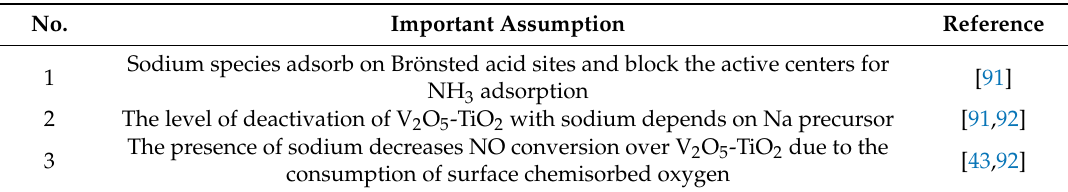
Table 3. The most important findings on the interaction of sodium with V 2 O 5 -TiO 2